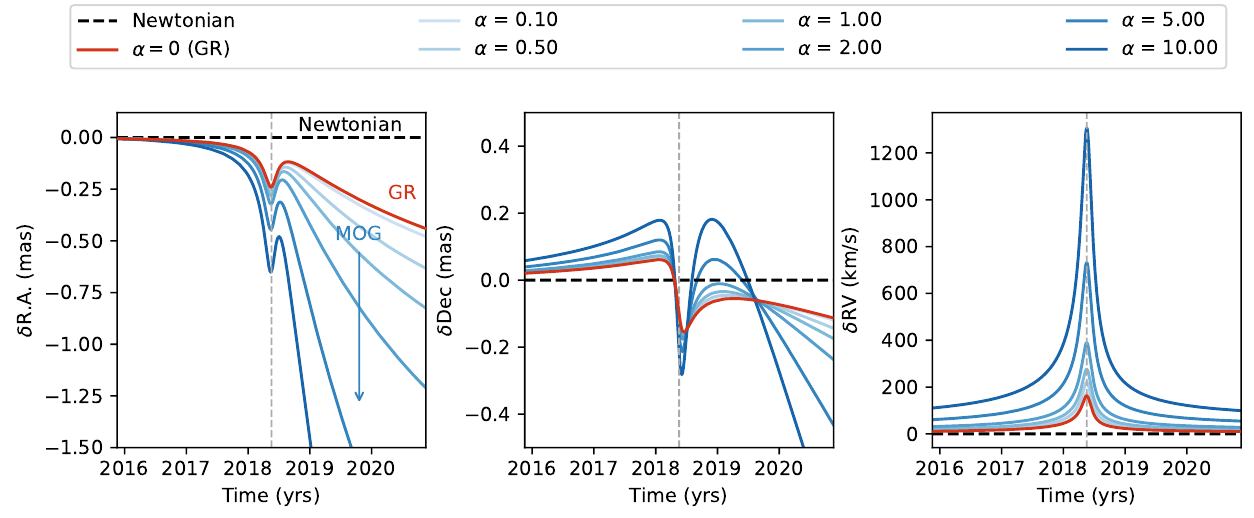
Figure 1. Numerically integrated sky-projected geodesic trajectories for the S2 star in pre- and post- pericentre (dashed vertical line) phase, for different values of the parameter α . In particular, we report the deviation from the Newtonian case (dashed horizontal black line) of the GR orbit ( α = 0, red line) and for increasingly higher values of α (in different shades of blue) on the right ascension direction ( left panel), on the declination direction ( central panel) and for the radial velocity ( right